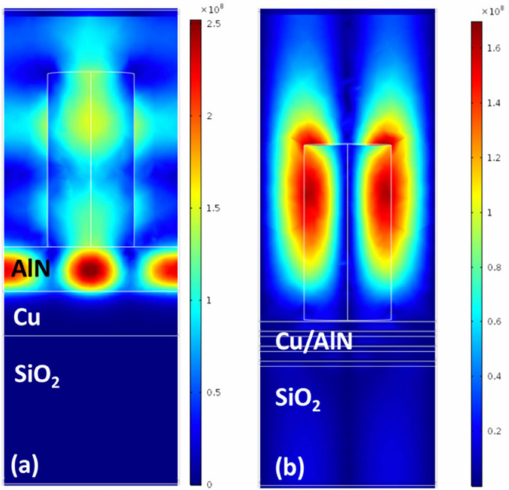
Figure 6. Electric field profile of the Ex component in the x-z plane for the ( a ) bilayer and ( b ) multilayer configurations at the operating wavelength equal to 645 nm and 624 nm, respectively. The impinging electric field is along the x-axis (Figure